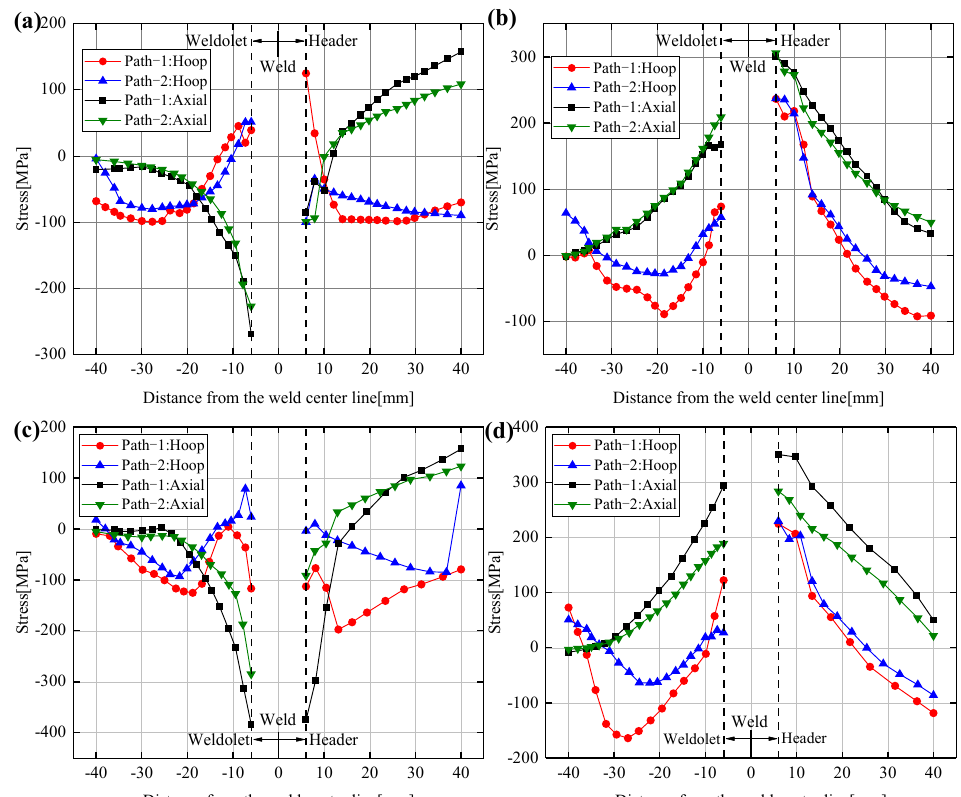
Figure 15. Hoop and axial residual stress distribution of Case3 and Case6 at the 0° and 180° sections: ( a ) Outer surface of the 0° section, ( b ) Inner surface of the 0° section, ( c ) Outer surface of the 180° section, ( d ) Inner surface of the 180° section.